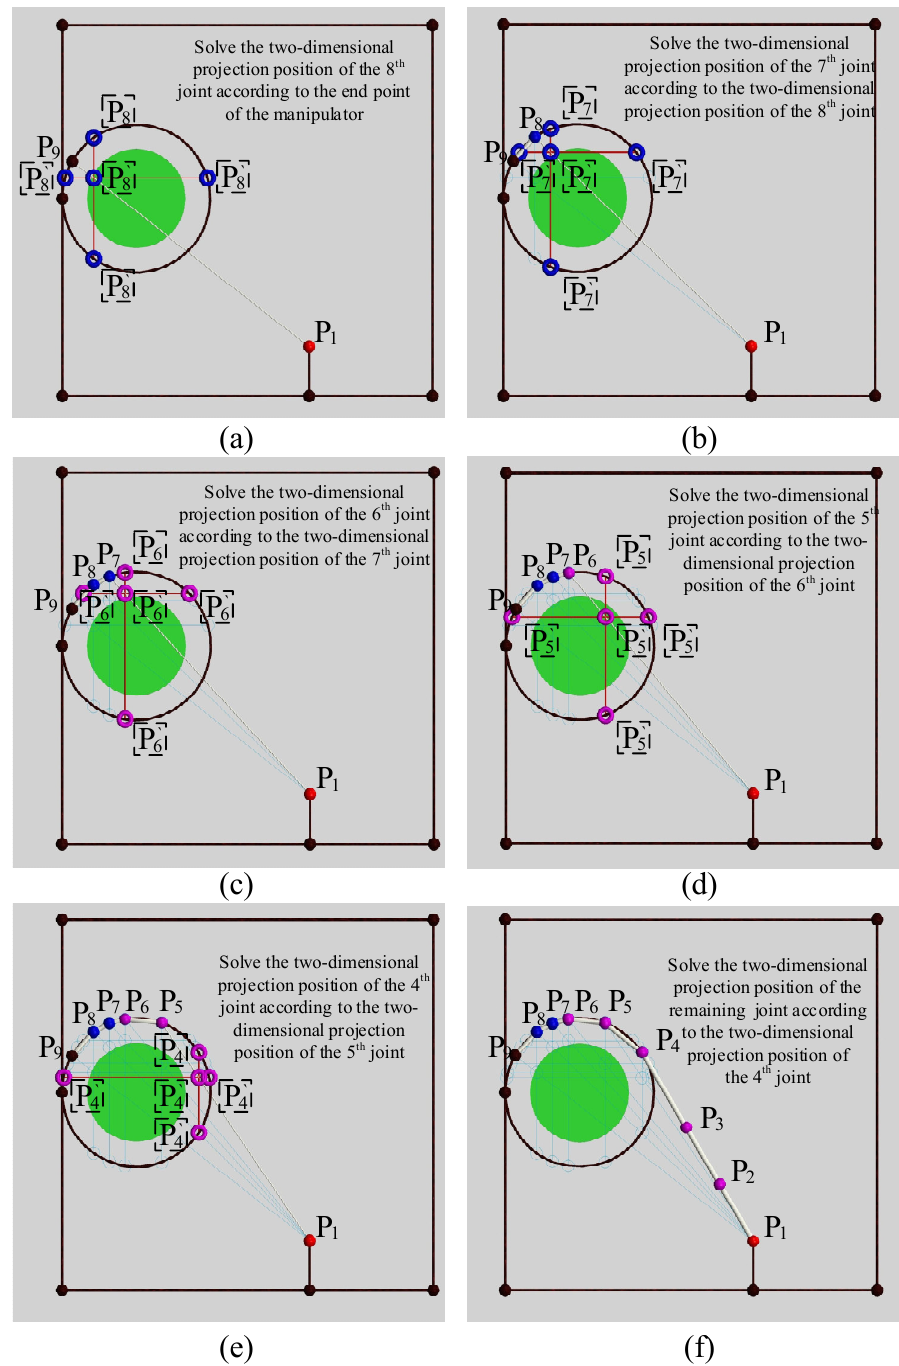
Figure 8. Process of solving the 2D projection positions of center points of each joint. ( a ) Solve 2D projection position of the 8th joint; ( b ) Solve 2D projection position of the 7th joint; ( c ) Solve 2D projection position of the 6th joint; ( d ) Solve 2D projection position of the 5th joint; ( e ) Solve 2D projection position of the 4th joint; ( f ) Solve 2D projection position of remaining joint.